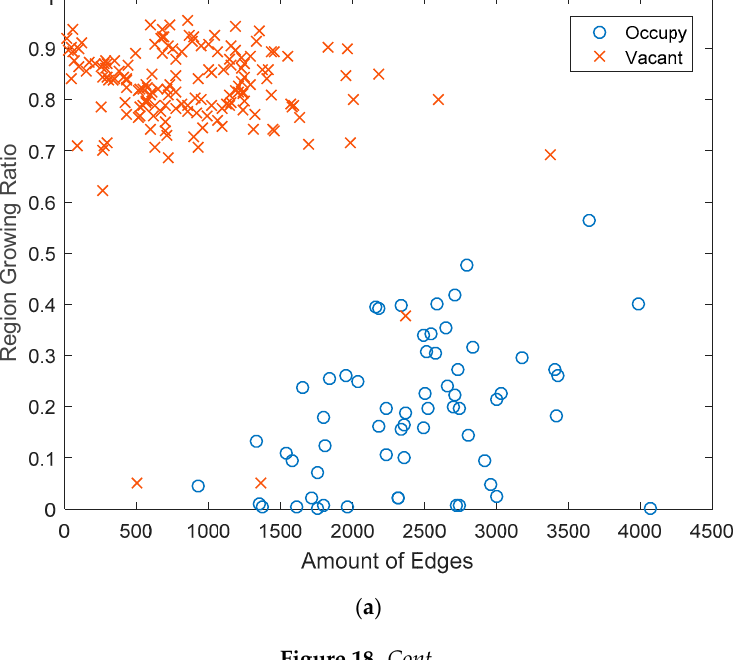
( b ) ( c ) Figure 18. Parallel parking training set. ( a ) Scatter plot of features; ( b ) Gaussian distribution of region growing ratio; ( c ) Gaussian distribution of number of edges.